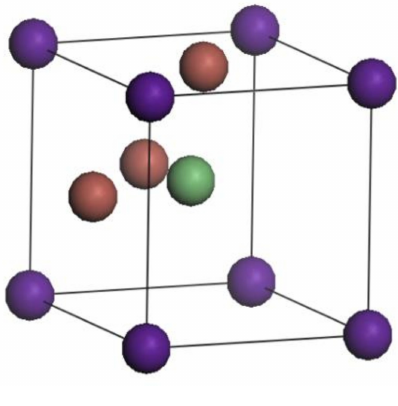
Figure 1. The crystal of CsGeI 3. Table 1. Lattice parameters of CsGeI 3 with Findit compared with geometry optimization